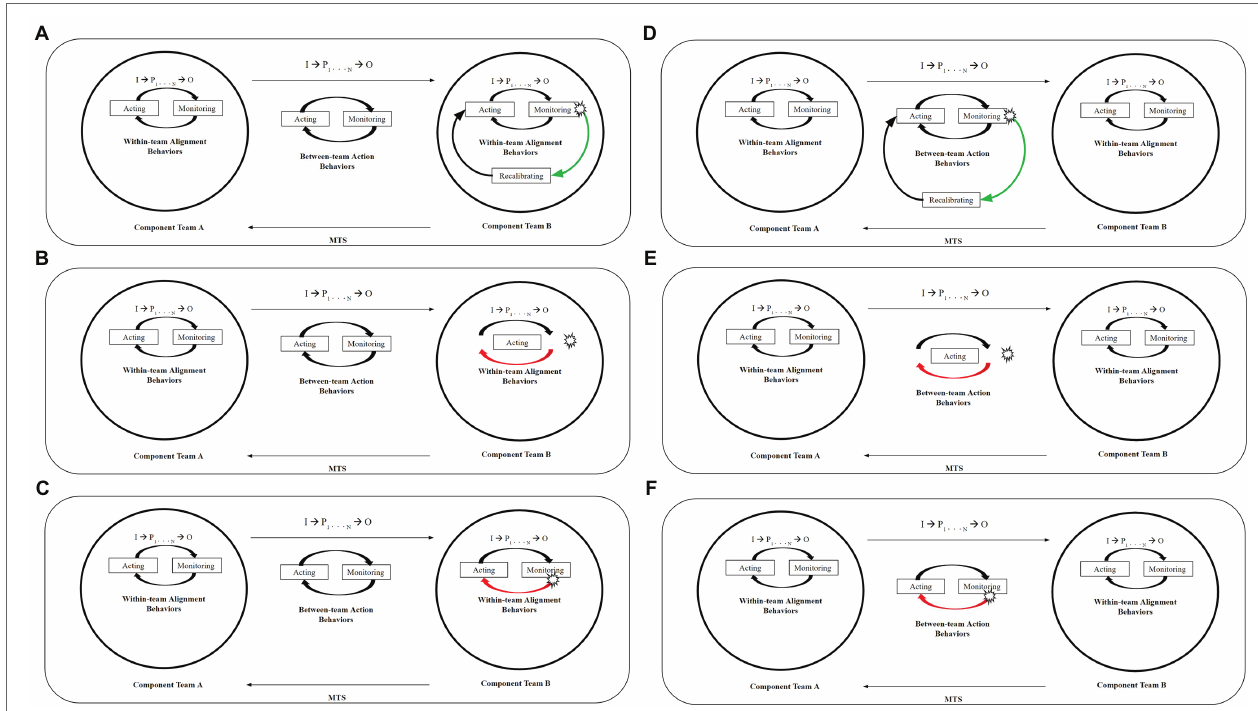
FIGURE 5 | Expanded MTS Action Subphase Model for Successful and Misaligned MTS Responses to Within- and Between-Team Triggers. All figures are adapted from the original MTS Action Subphase model presented in Torres et al. (2021). Solid black rectangle represents the MTS boundary. Outlined circles represent component team boundaries. Straight arrows represent between-team interdependence. Trigger is indicated by blast shape. Curved arrows represent subphase relationships. Green curved arrow represents an appropriate response to the trigger. Red curved arrow represents an inappropriate response to the